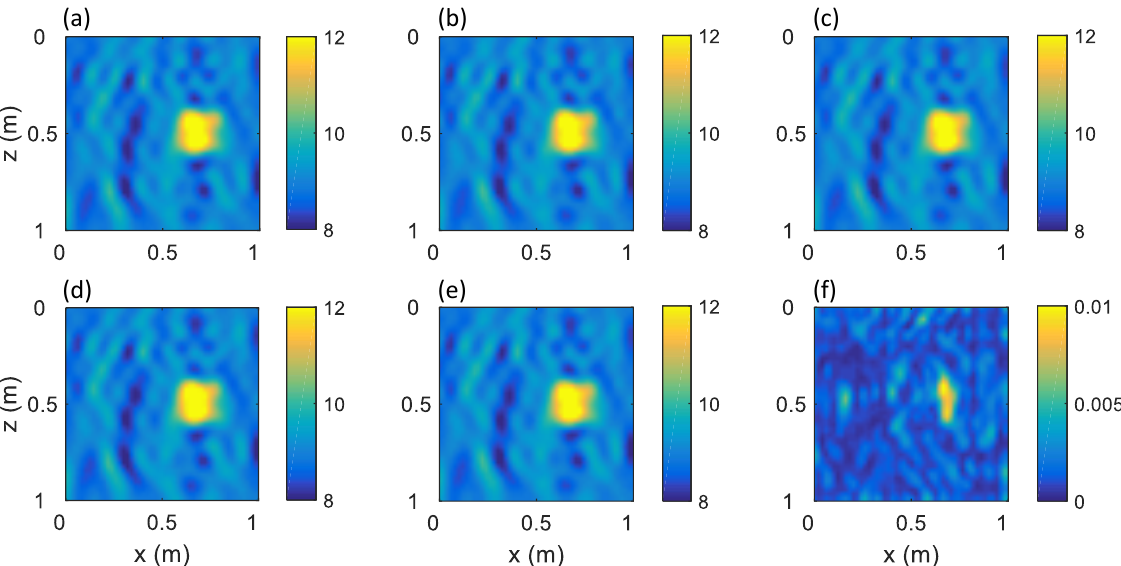
Figure 9. Posterior solutions using the FDTD model with waveform data: ( a – c ) three randomly selected realizations from the posterior distribution, ( d ) the maximum a-posteriori (MAP) density solution, ( e ) the posterior mean realization, and ( f ) variance of the posterior